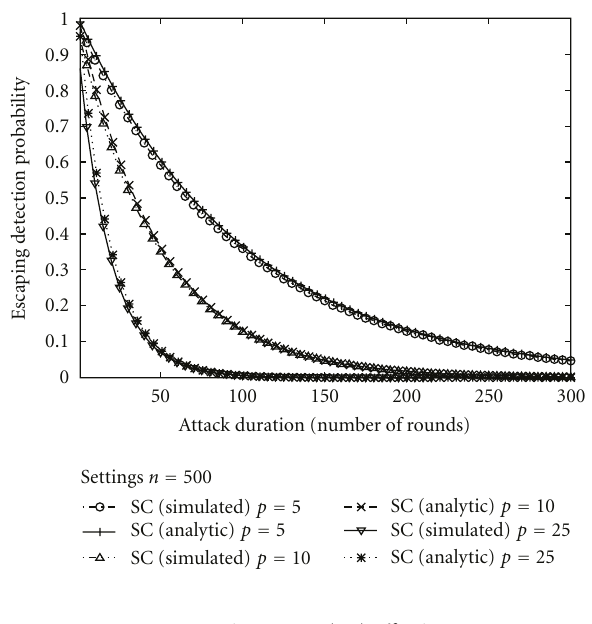
Figure 2: Static counter (SC) e ff ectiveness. Figure 3: Dynamic counter (DC) e ff ectiveness.